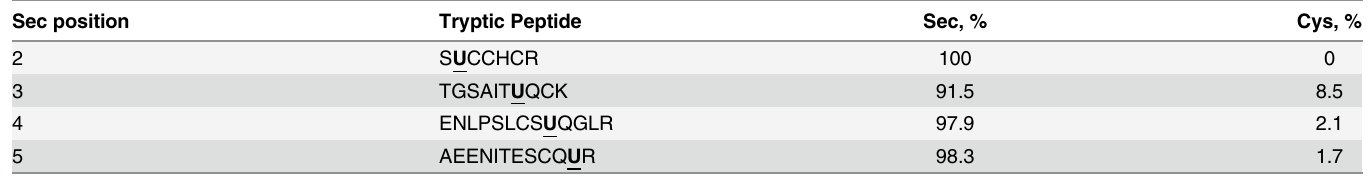
Table 2. Tryptic Sec-containing peptides of SelP isolated from pooled (n = 5) human